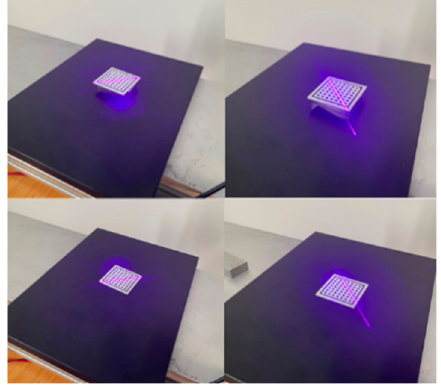
Figure 9. Calibration of the laser line plane.